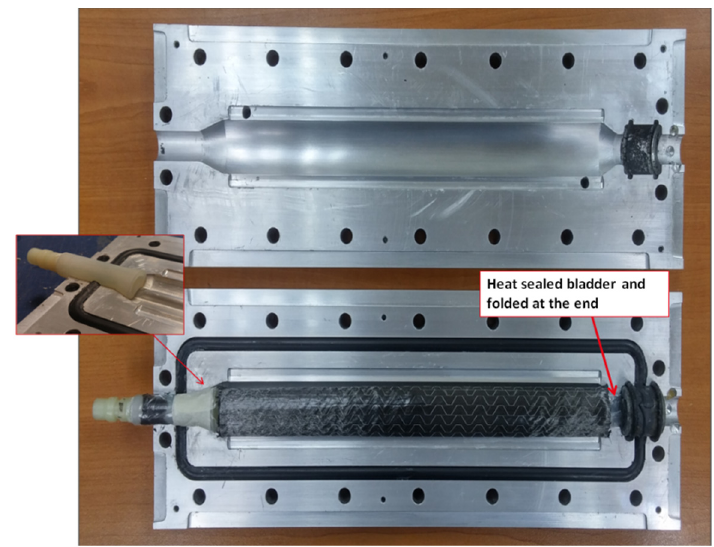
Figure 8. Preform positioning in the mold.